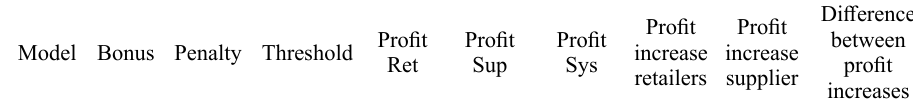
Table 4. Chosen values in scenario analysis for VMIINV